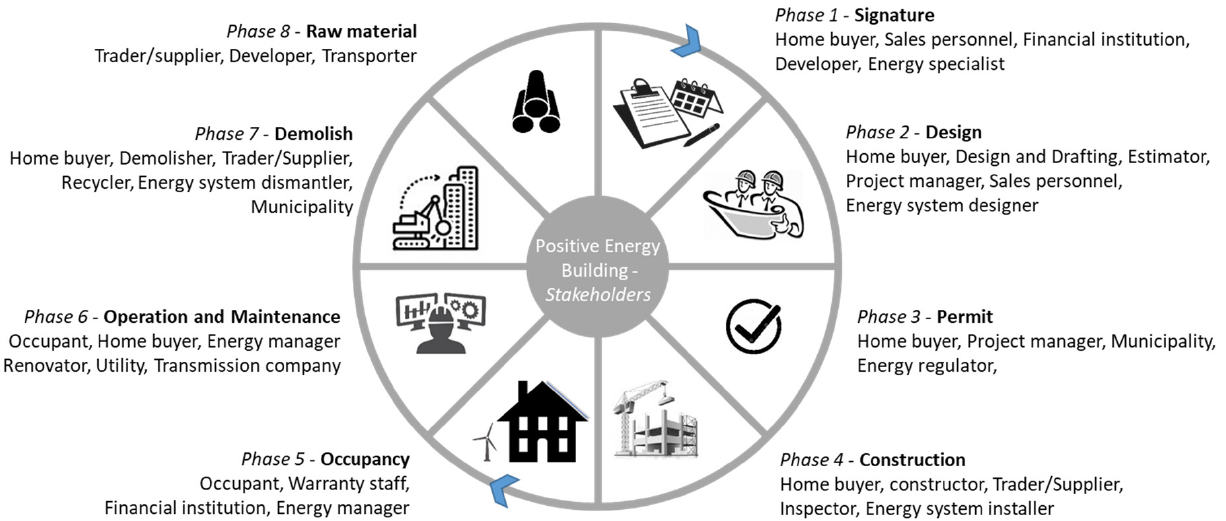
Figure 6. Role of stakeholders at different phases of PEBs in a life-cycle [127–129,132]. Partially reprinted with the permission from [128].